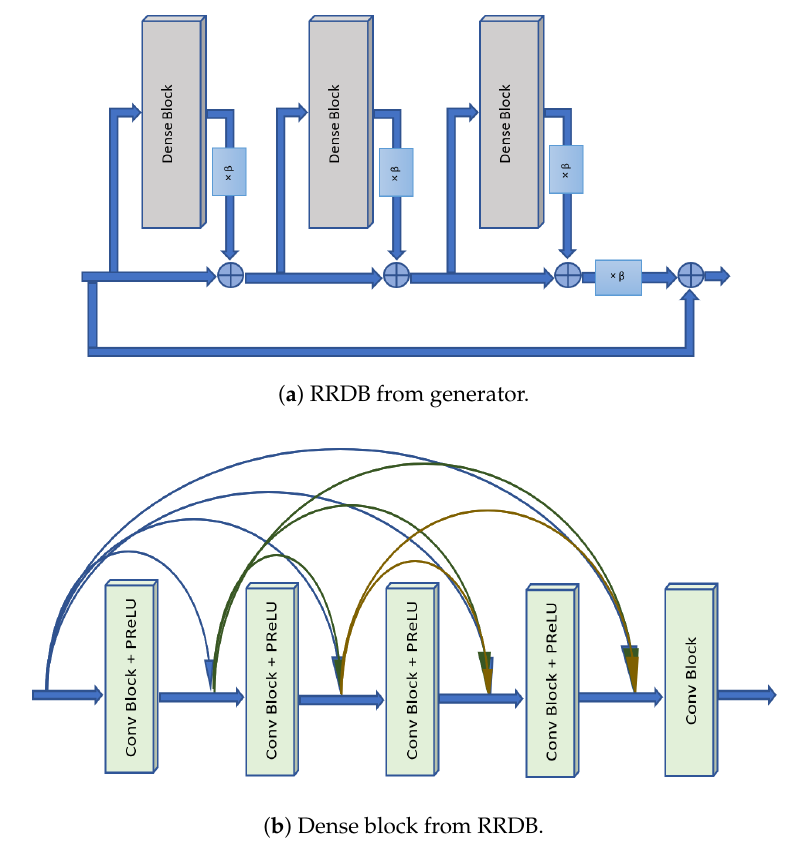
Figure 4. Internal diagram of RRDB (residual-in-residual dense